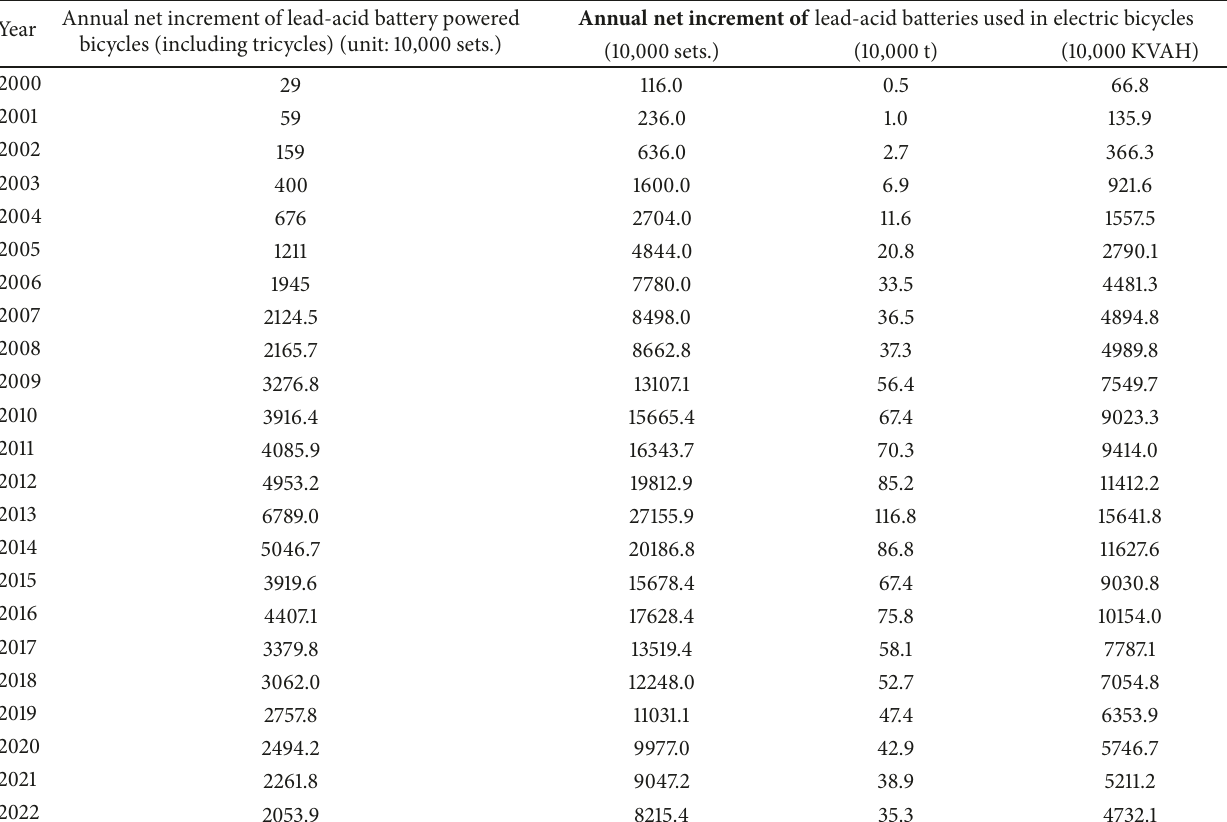
Table 9: Annual net increment of lead-acid batteries used in electric bicycles in 2000-2022.